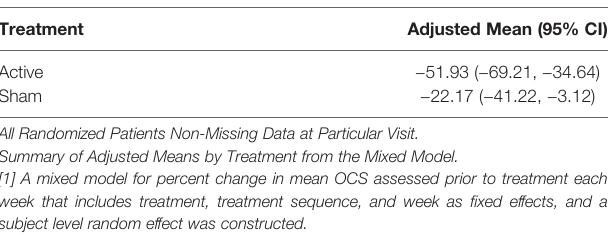
TABLE 5B | Summary of Mixed Model for Percent Change in Mean OCS.